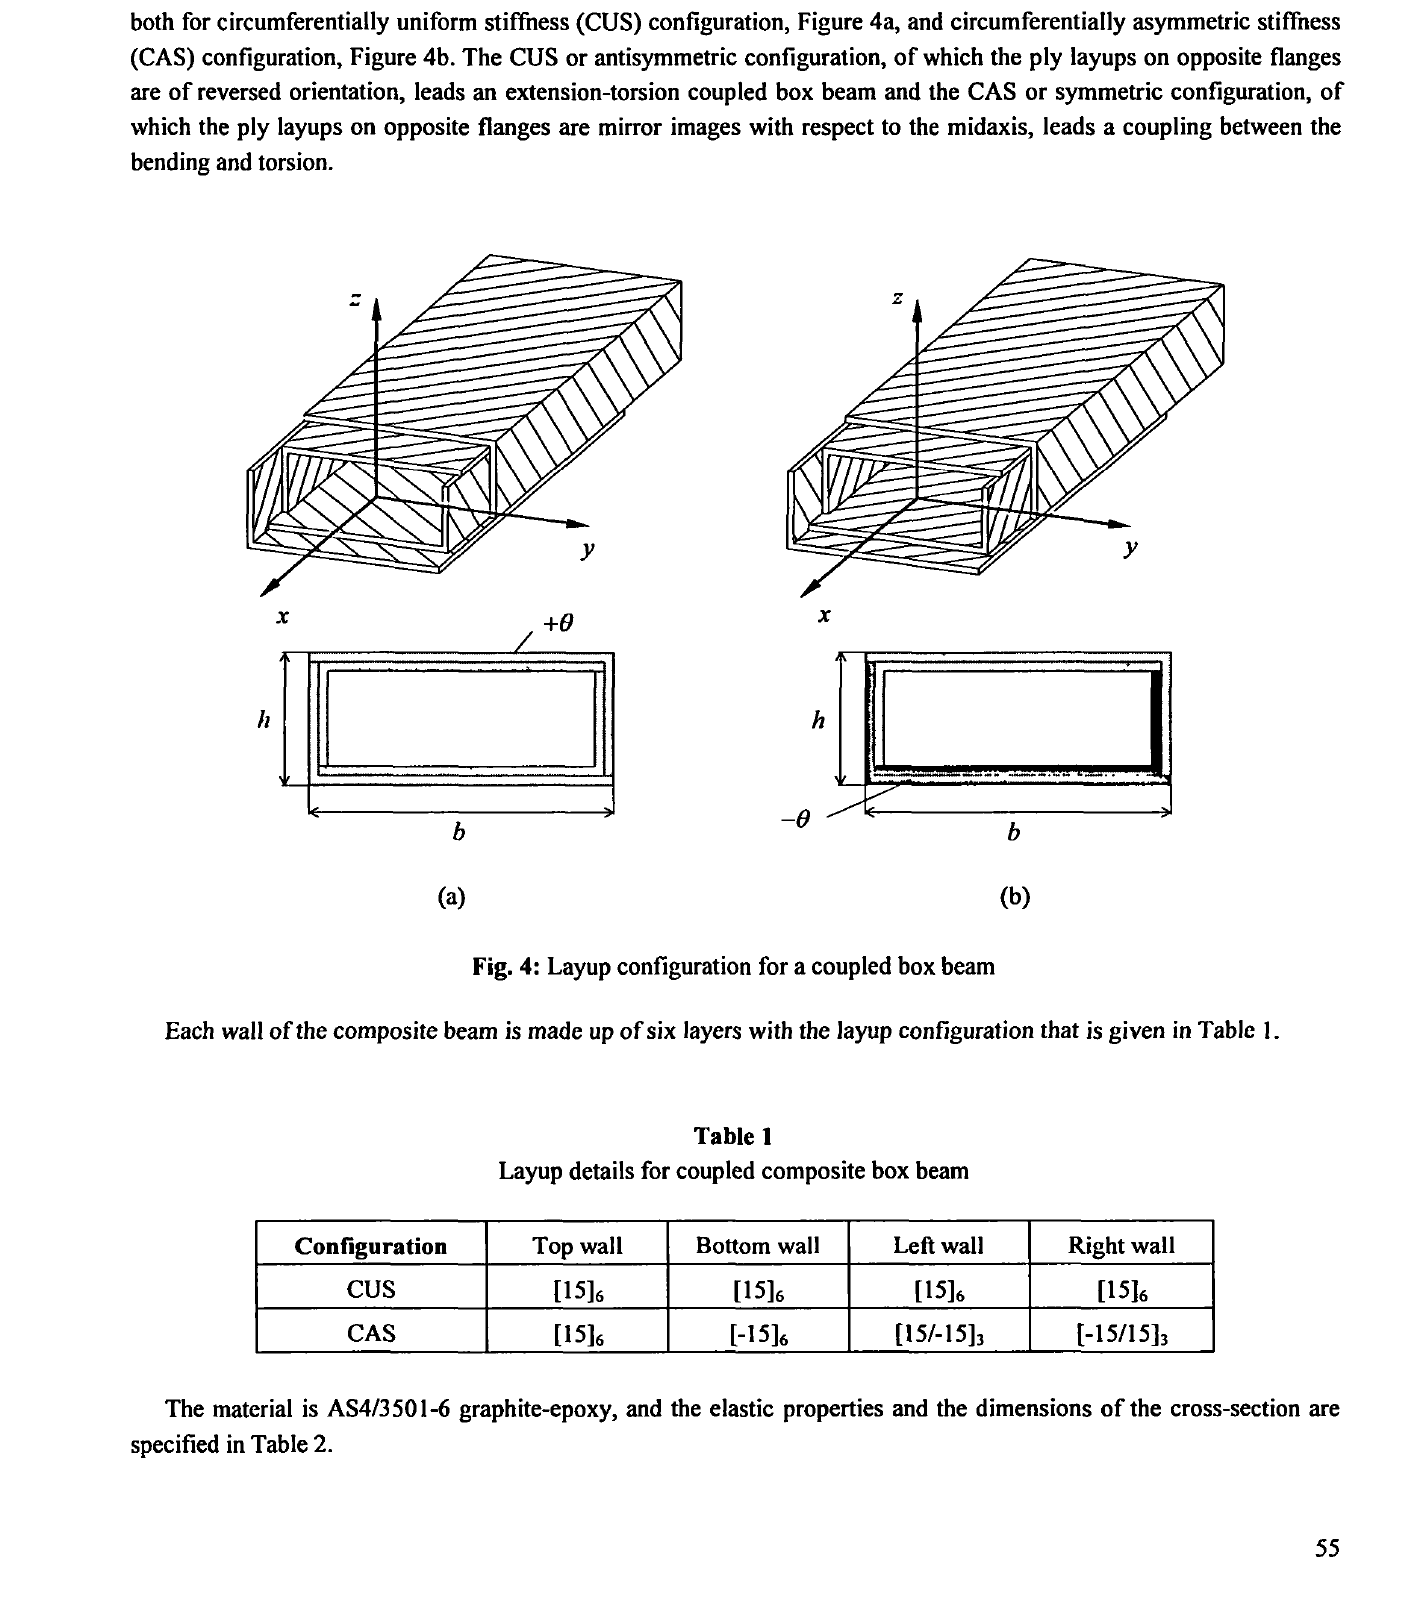
Fig. 4: Layup configuration for a coupled box